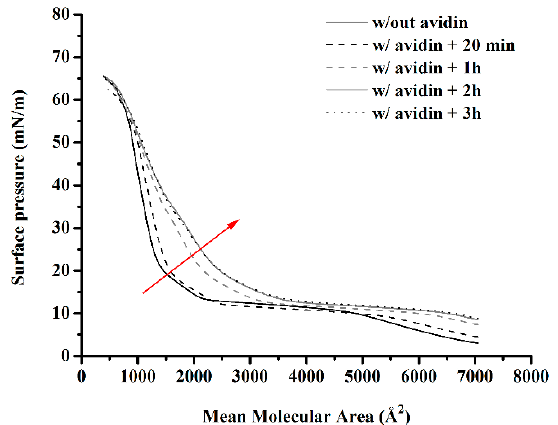
Figure 8. Langmuir surface pressure-area isotherm of P(PEGA 40 )- b -(MMA- co -BA)-TTC (VA-044 at 70 °C, 4 h) mixed with biotin, using aqueous avidin solution as the subphase and varying the contact time before compression starts.